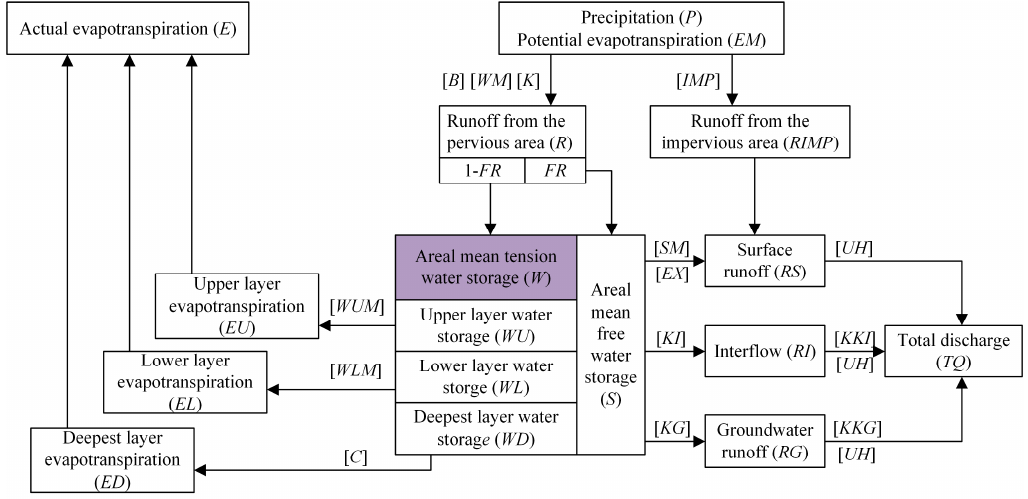
Figure 3. Flow chart for the Xinanjing model. This model is driven by precipitation and potential evapotranspiration, and the main outputs are actual evapotranspiration, total outflow, and soil moisture content. It generates runoff from both pervious area ( FR ) and impervious areas (1- FR ). This paper choses areal mean tension water storage ( W ) (purple-shaded) as the XAJ model-simulated soil moisture content. The symbols in square brackets such as [ K ] represent the model parameters, while the symbols in brackets such as ( EW ) represent state variables.